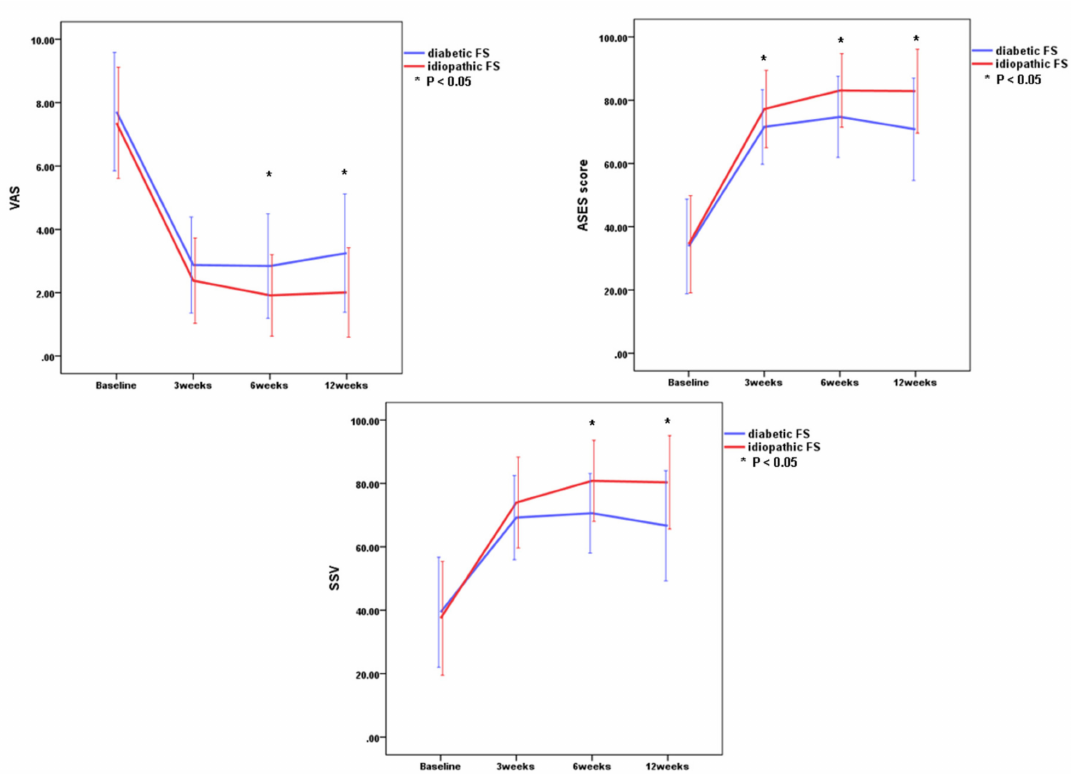
Figure3. Comparisonoffunctionalscores(VAS,ASESscore, SSV)betweenthetwogroups. Asteriskindicates significant di ff erences between the idiopathic frozen shoulder group and the diabetic frozen shoulder group at each time point. VAS, visual analog scale; ASES, American Shoulder and Elbow Surgeon score; SSV, subjective shoulder value. Error bar means one standard